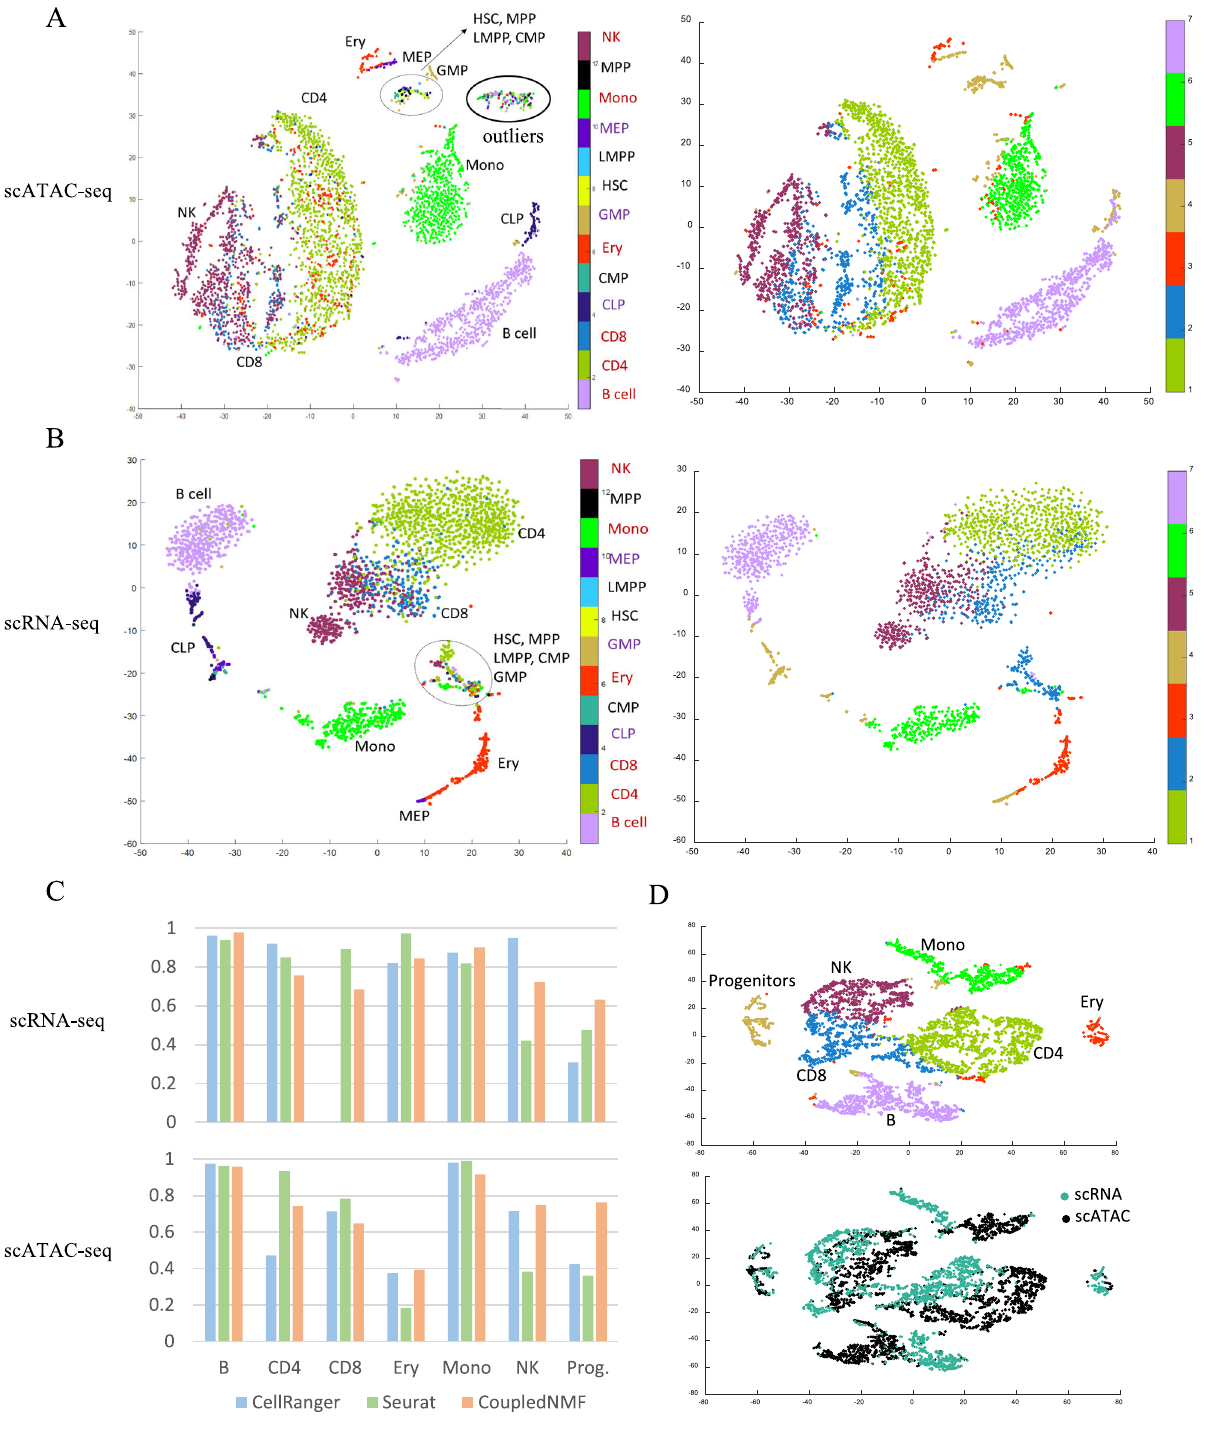
Fig. 3 Validation of joint clustering and joint embedding on the normal sample. A t-SNE plots of scATAC-seq data colored by true label (left) and clustering label from coupled NMF(right). B t-SNE plots of scRNA-seq data colored by true label (left) and clustering label from coupled NMF(right). C Comparison of the true label and clustering label for scATAC-seq (up) and scRNA-seq (down). D Joint embedding of scATAC-seq and scRNA-seq by using t-SNE on low dimension loading matrixes from coupled